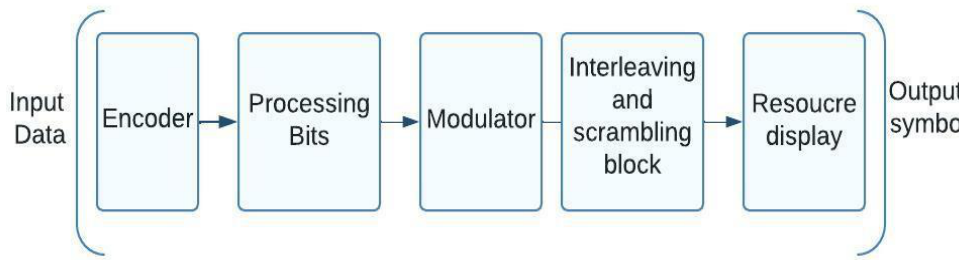
Figure 8. NOMA system structure with interleaving and zero elements.